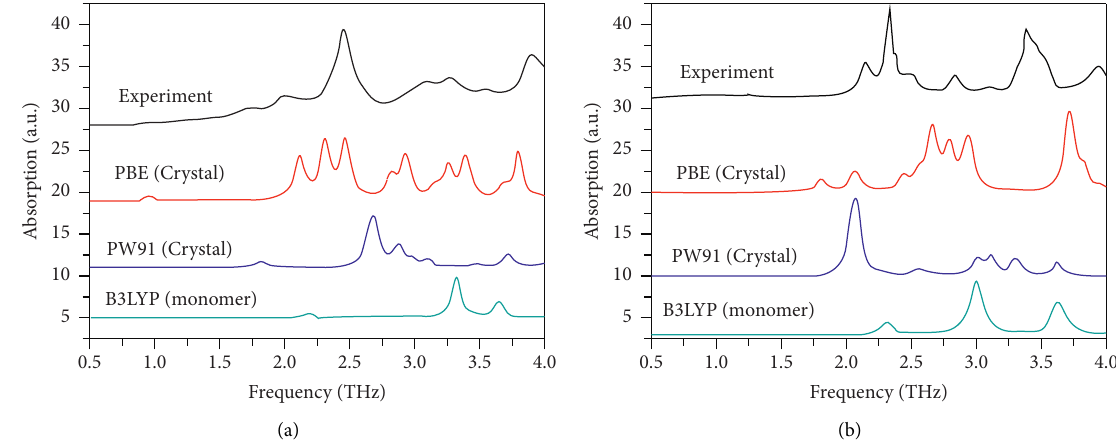
Figure 4: The experimental absorption spectra of (a) mannose and (b) galactose compared with the simulated THz spectra of the solid-state model using PBE and PW91 functionals and that of isolated molecule model using B3LYP functional. Table 4: Comparison of the absorption peaks between the experimental and best-fit calculated spectra and the mode descriptions of mannose and galactose. Mannose Mode Exp. Cal. Mode description